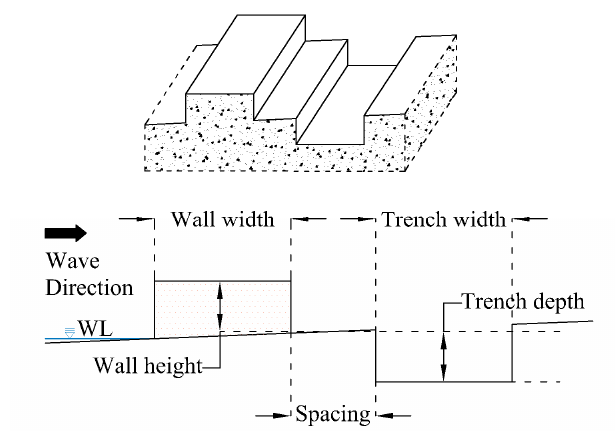
Figure 2. Geometry of the combined wall and trench system. Table 2. Description of simulation cases with details of onshore structures (in real scale).